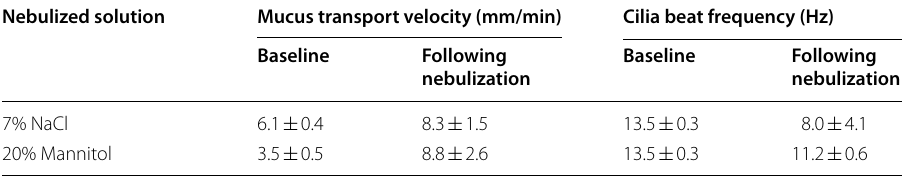
Results are presented as the mean